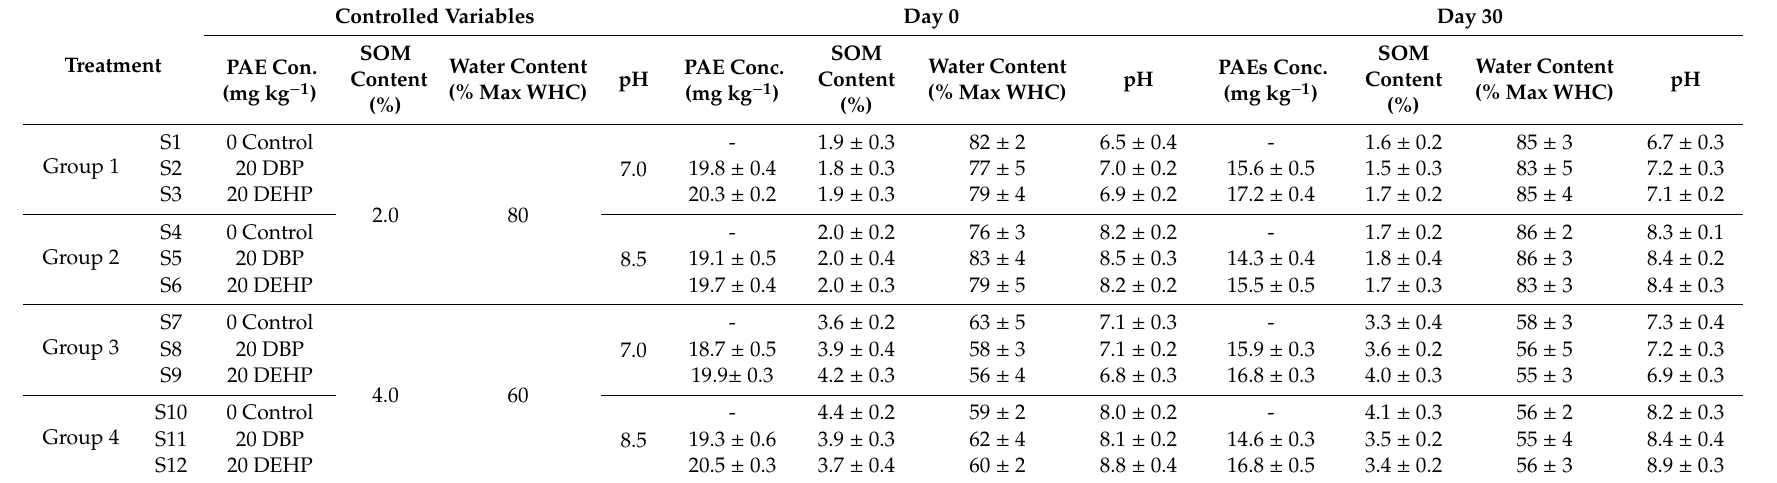
Table 1. Controlled variable results from the experimental treatments at the start and end of the toxicity